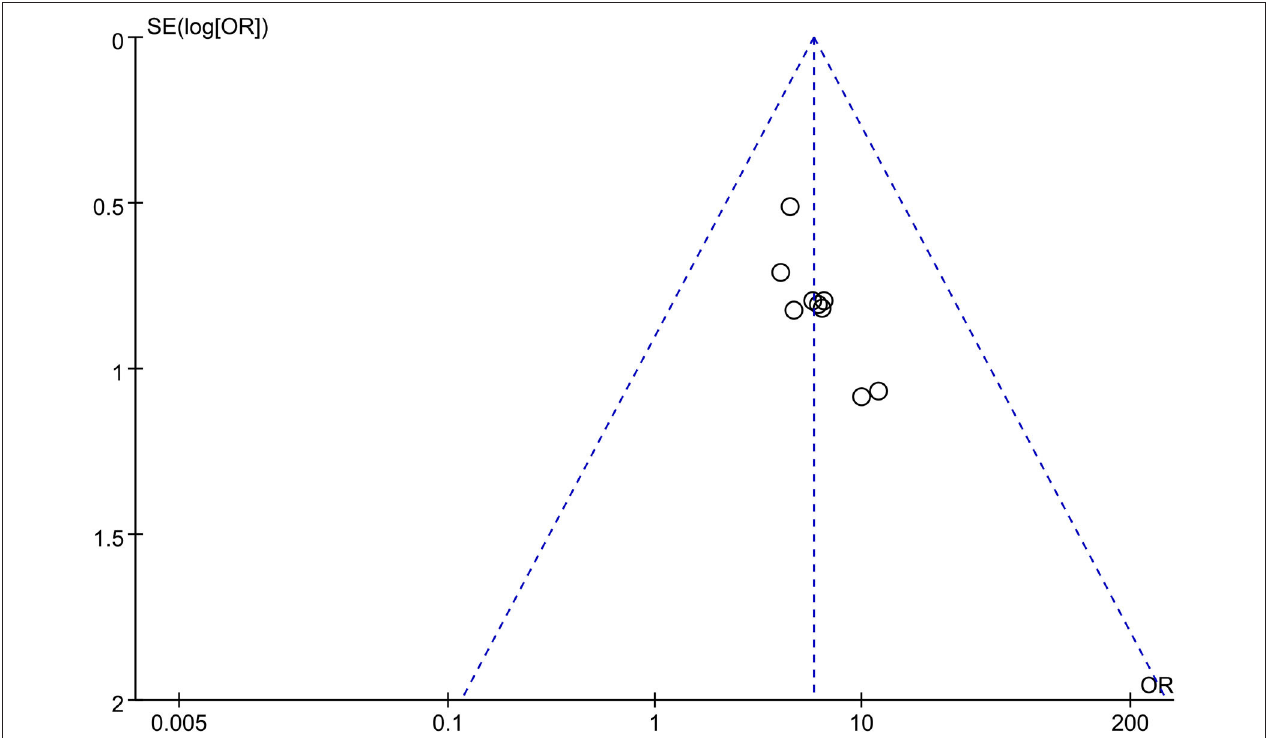
FIGURE 11 | Funnel plot of the clinical efficacy rates: combination therapy vs. prednisone.